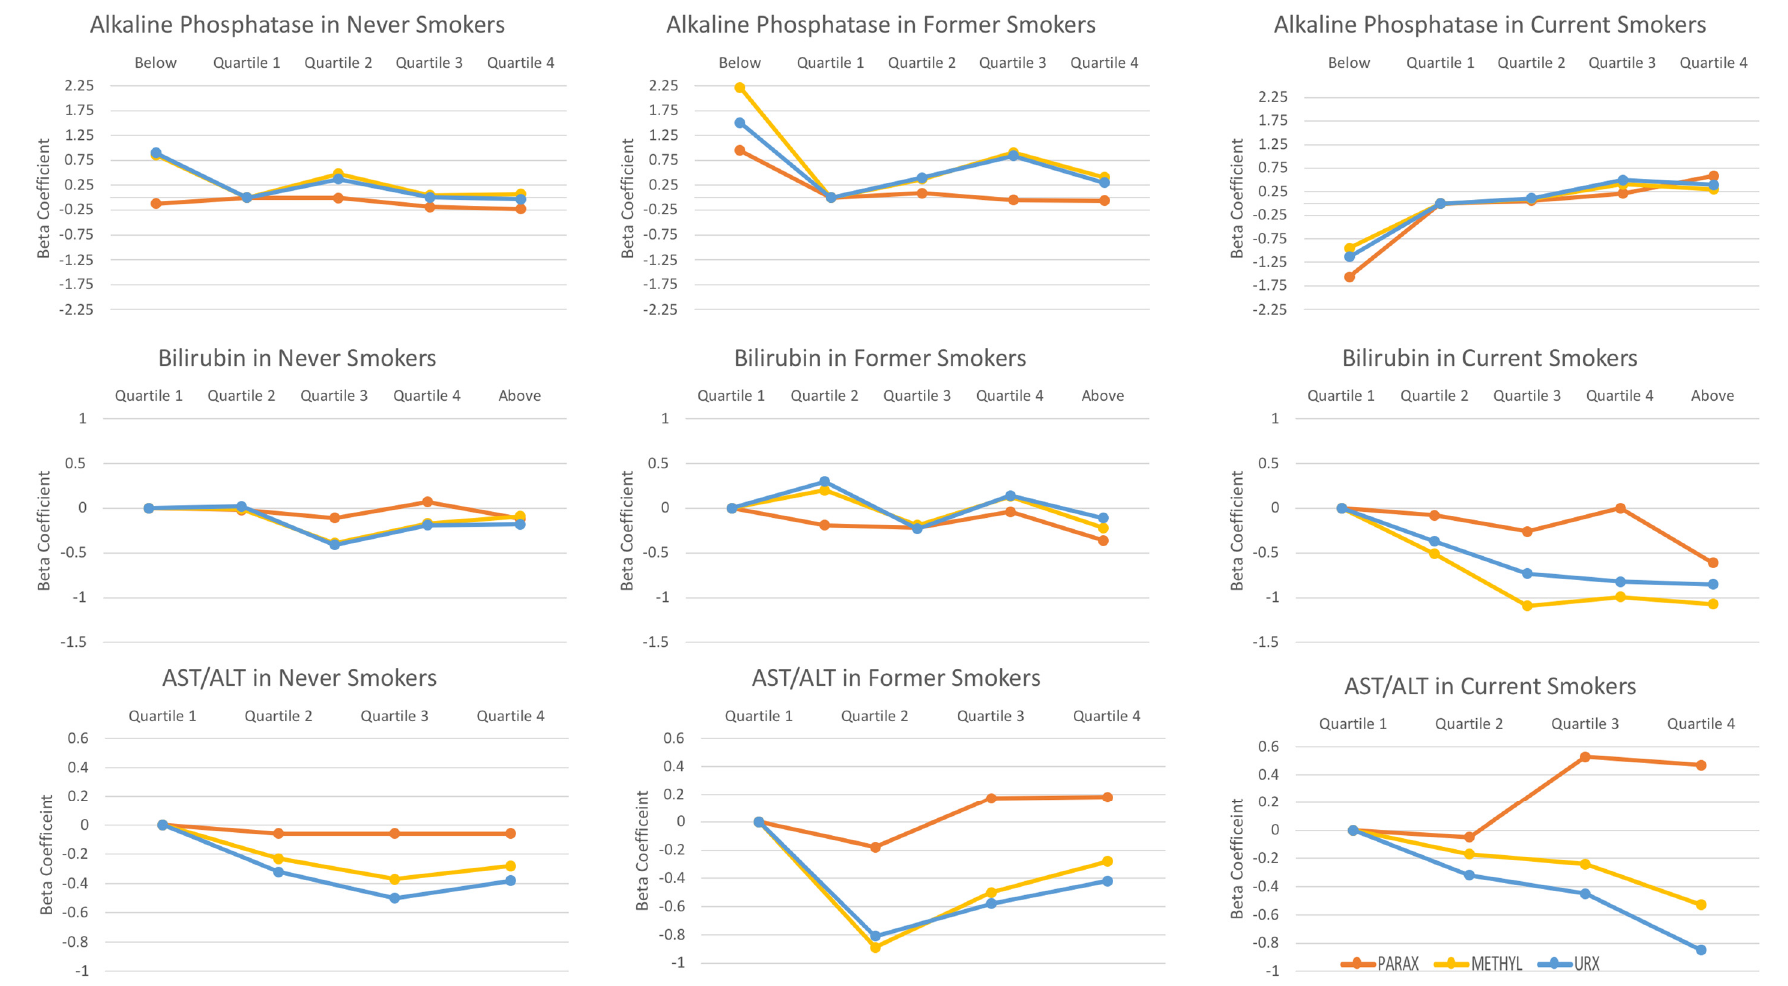
Figure 2. Patterns of selected liver enzyme levels with some caffeine metabolite indices in never, former, and current smokers. The covariates adjusted in multivariable models included age, gender, ethnicity, body mass index, physical activity, diabetes, hypertension status, liver condition, glomerular filtration rate, fasting status, serum cotinine, and total smoking intensity. PARAX: Paraxanthine; METHYL: 1-methyluric acid; URX: 5-acetylamino-6-amino-3-methyluracil.